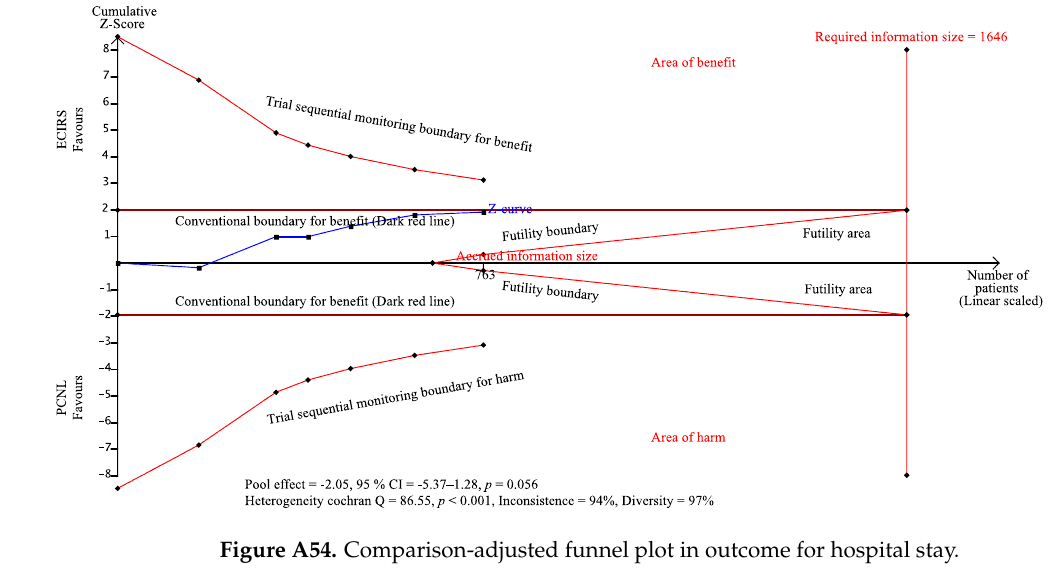
Figure A54. Comparison-adjusted funnel plot in outcome for hospital stay.